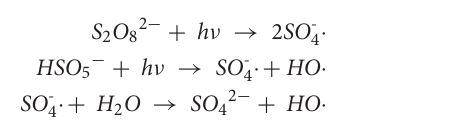
to the pH of the aqueous